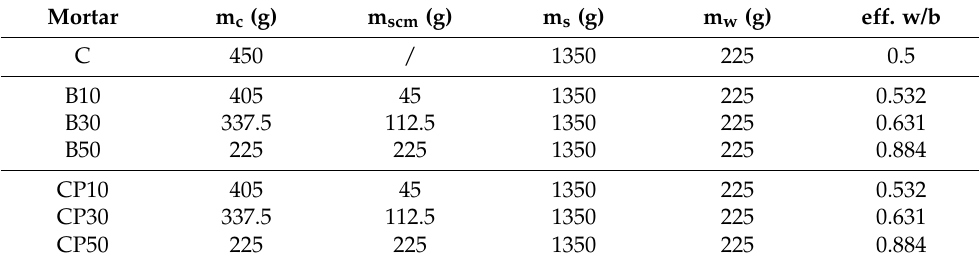
Table 1. Labels and component materials for mortars and the effective w/b. Mortar m c